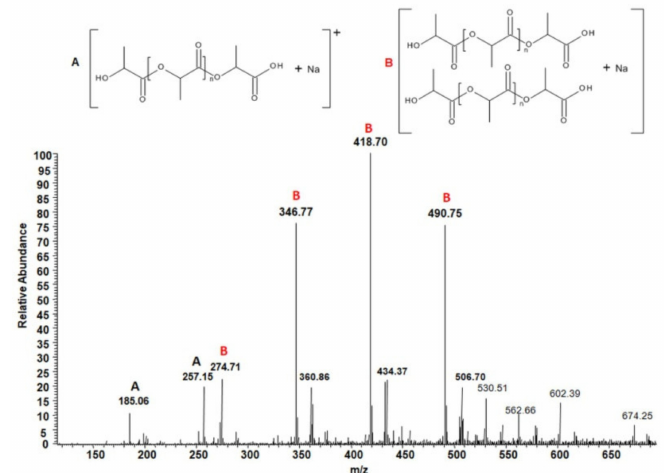
Figure 8. ESI-mass spectrum (positive-ion mode) of the degradation products released from the welded PLA 2 to the water after 9 months of